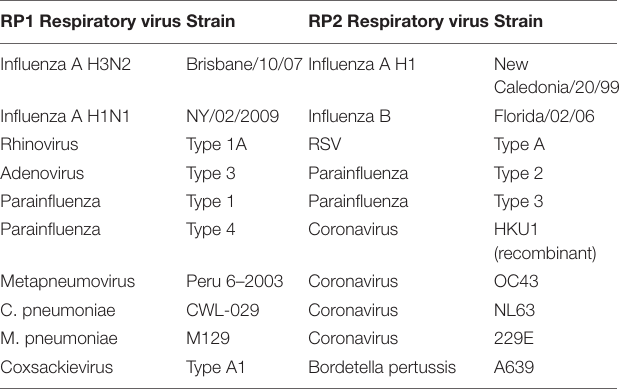
TABLE 2 | Respiratory pathogens included in the NATtrol RP multimarker controls